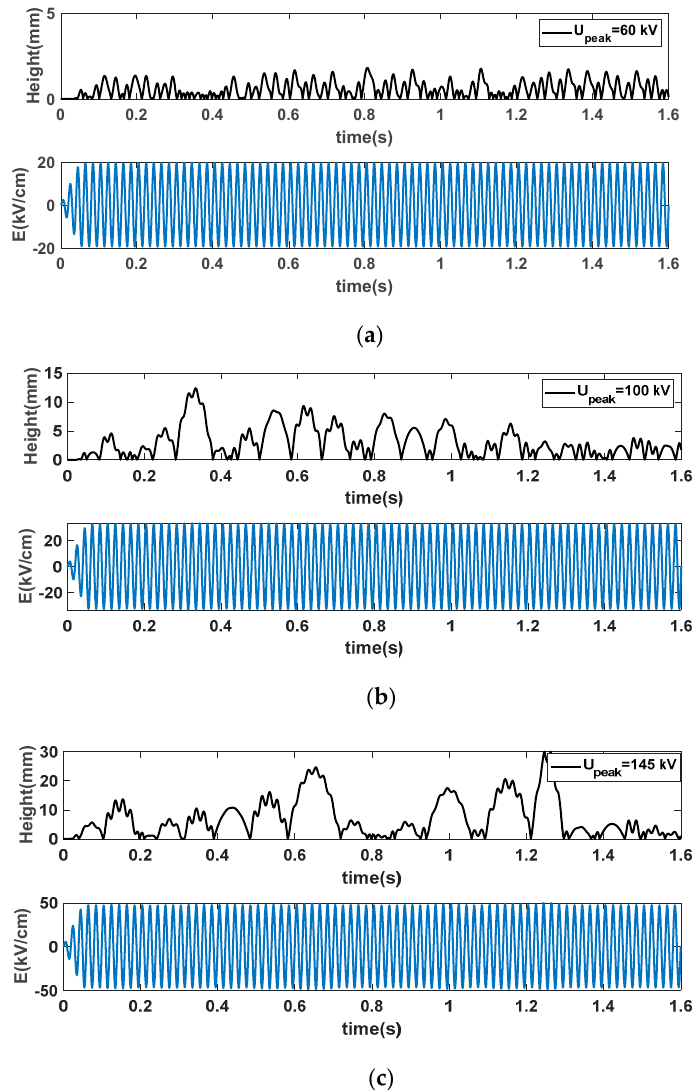
Figure 7. Simulated movements for a 4 mm particle in set-up 1 filled with CO 2 /O 2 at 0.75 MPa. Applied voltage 60 ( a ), 100 ( b ), and 145 kV peak ( c ). Particle vertical movement (top plots) and electric field strength at the center of the particle location (bottom plots). In the simulations the voltage was ramped up to the maximum voltage within 50 ms.